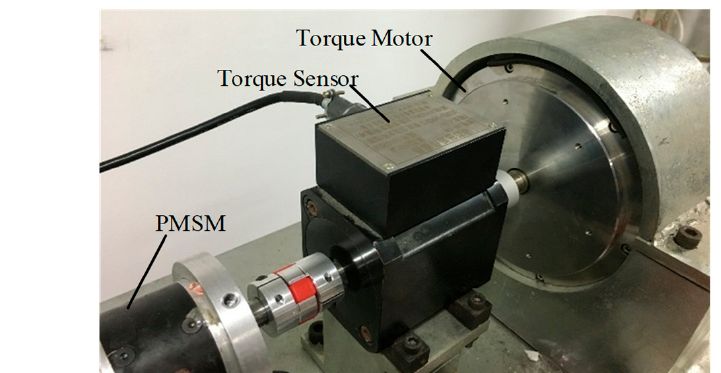
Figure 19. Load torque test equipment.